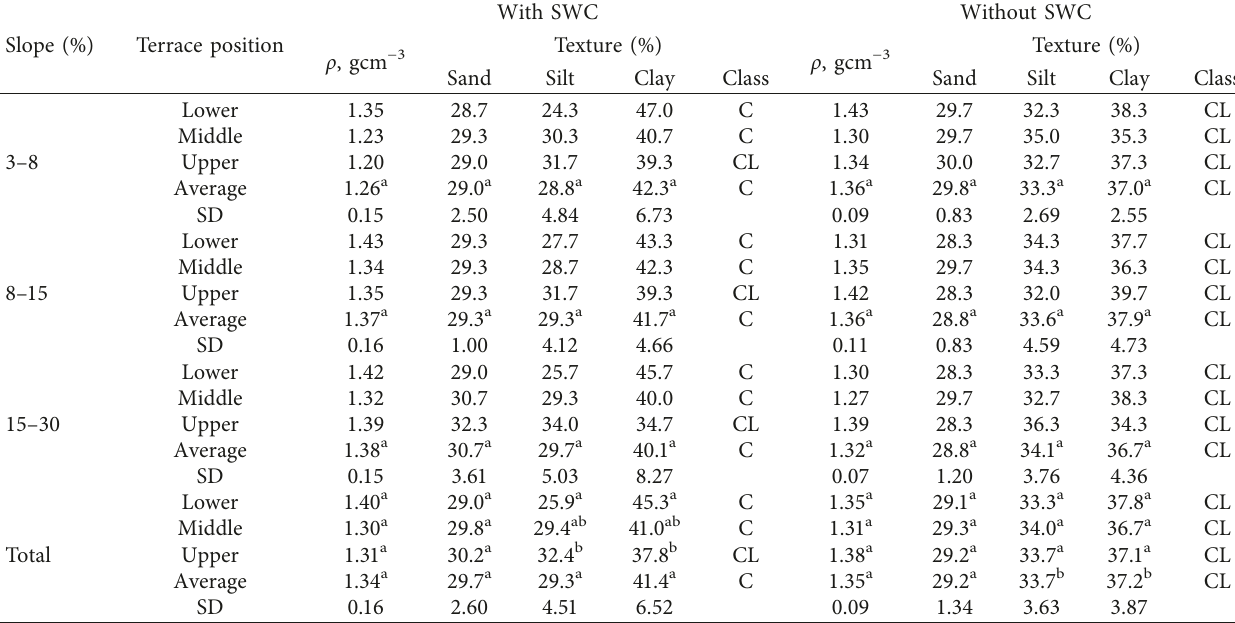
Table 3: Mean values of dry bulk density (gcm − 3 ) and soil textures in 0.0- to 20.0cm soil depth in the Geshy subcatchment. With SWC Without SWC Slope (%) Terrace position